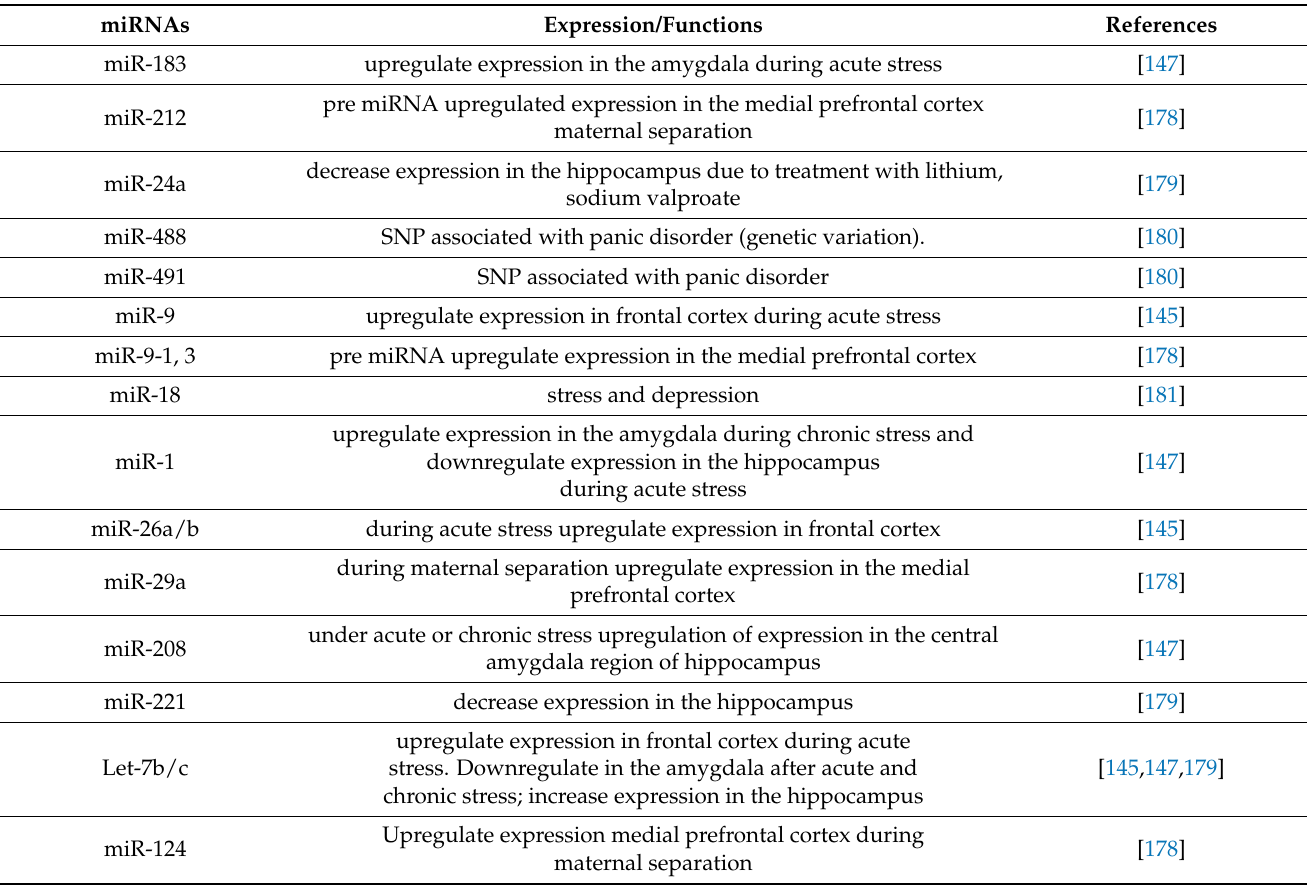
Table 1. Role of micro RNAs in anxiety and